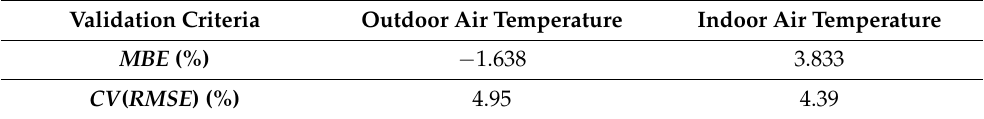
Table 4. Validation criteria values of the simulation model.